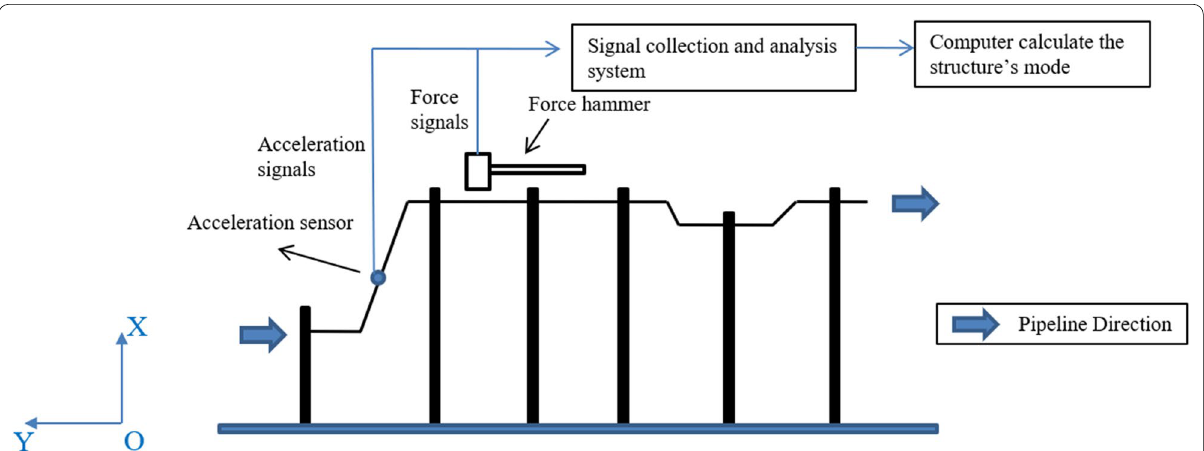
Figure 11 Schematic diagram of mode